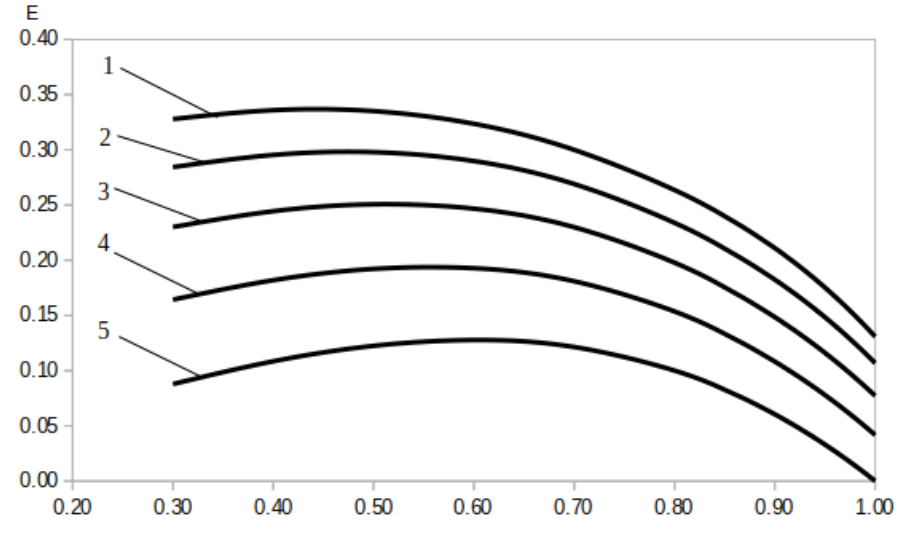
( α , γ ) subject to the value of the parameter γ for: (1) α = 0.8; RE